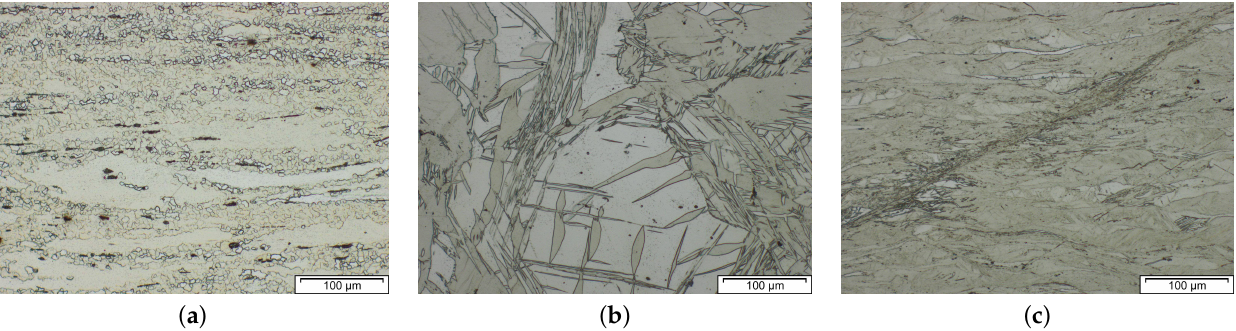
Figure 2. Examples of microstructural features common in deformed Mg alloys. Pictures show a Mg–Al–Ca lean alloy produced at LKR Light Metals Technologies Ranshofen in an as-forged state. ( a ) Necklace structure; ( b ) twins; ( c )